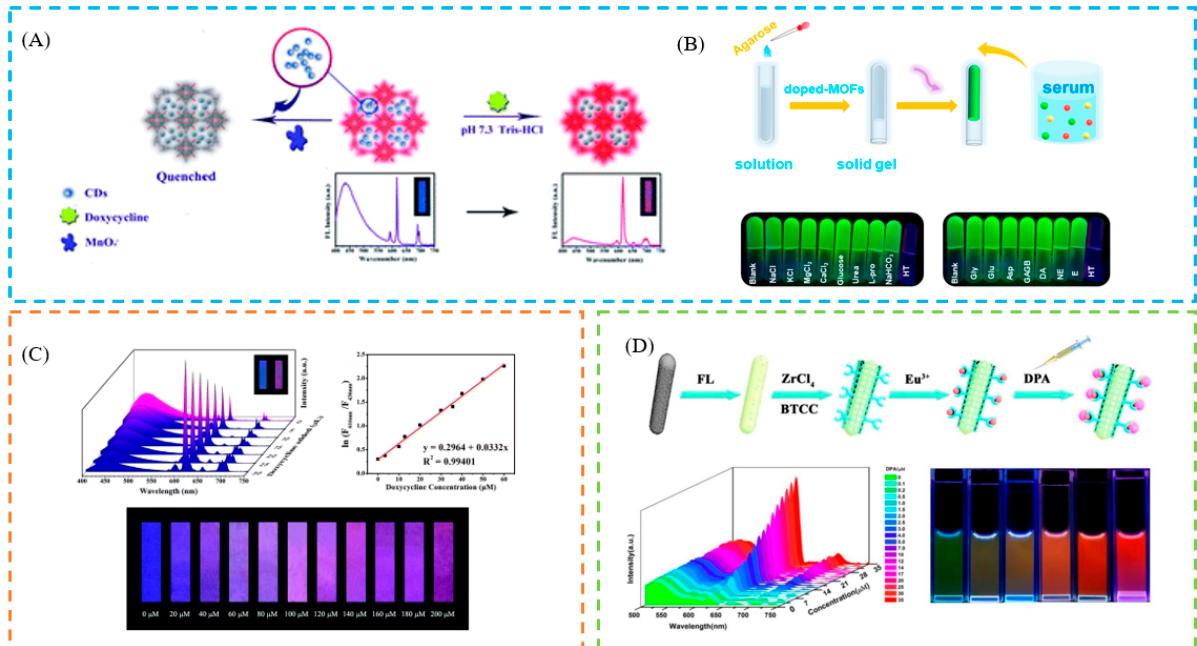
Figure 9. ( A ) Schematic illustration of the process for sensing doxycycline, based on fluorescent CDs@MOF. ( B ) Schematic illustration of the mechanism for BR detection by Tb 3+ @MOF-808 and photographs of the fluorescent filter paper strips sprayed with various analytes. ( C ) The color change of test paper with the concentration of doxycycline. ( D ) Schematic illustration of the prepa- ration of a Pal@FL@UiO-66-(COOH) 2 -Eu nanoprobe and the multicolor fluorescence detection of DPA and the fluorescence images of Pal@FL@UiO-66-(COOH) 2 -Eu in the presence of DPA. Repro-